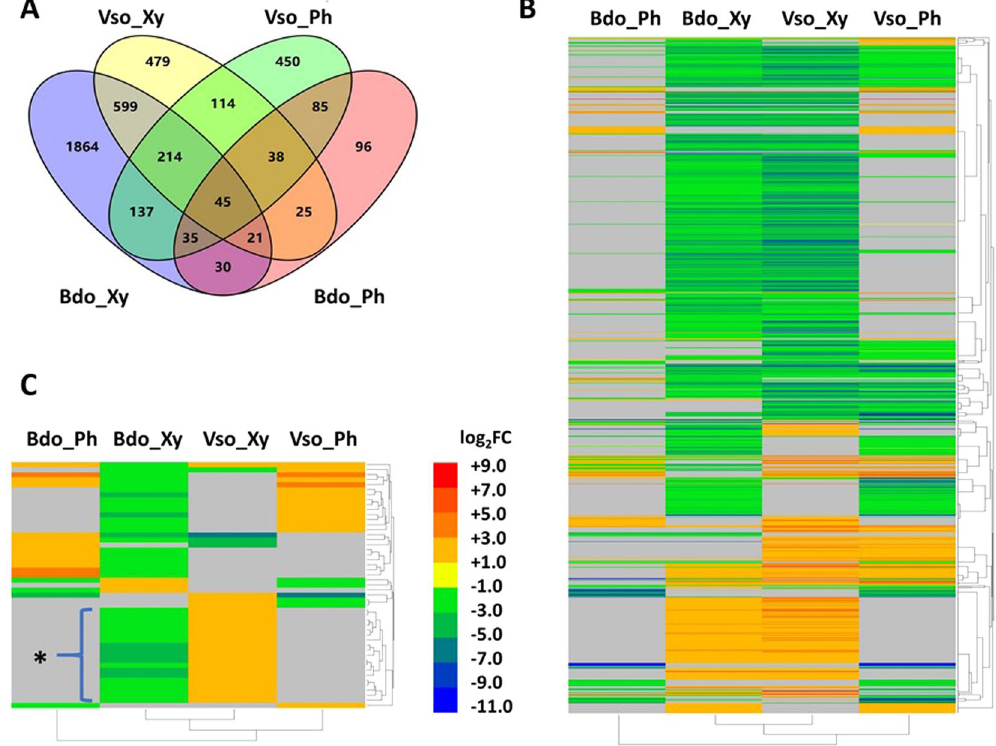
Figure 2. Co-expressed DEGs in stems of poplar infected with pathogen Botryosphaeria and Valsa . ( A ) Venn diagram of DEGs in phloem and xylem of Botryosphaeria and Valsa infected poplar stems. ( B ) Heatmap of co-expressed DEGs in phloem and xylem of Botryosphaeria and Valsa infected poplar stems. ( C ) Heatmap of divergently regulated poplar DEGs. For the DEG that only detected in pathogen treatments library or in control library, their expression (log 2 FC value) was set as 8.0 and − 11.0 respectively because the log 2 FC value of the most up-regulated DEG (Potri.013G126500, function unknown) was 7.95 and the log 2 FC value of the most down-regulated gene (Potri.008G101600, encoding gibberellin 2-beta-dioxygenase) was − 10.97. Grey indicates genes did not significantly differentially changed in this treatment. Asterisk in panel C indicates 19 divergently regulated DEGs that only be detected in xylem of pathogen Botryosphaeria and Valsa infected